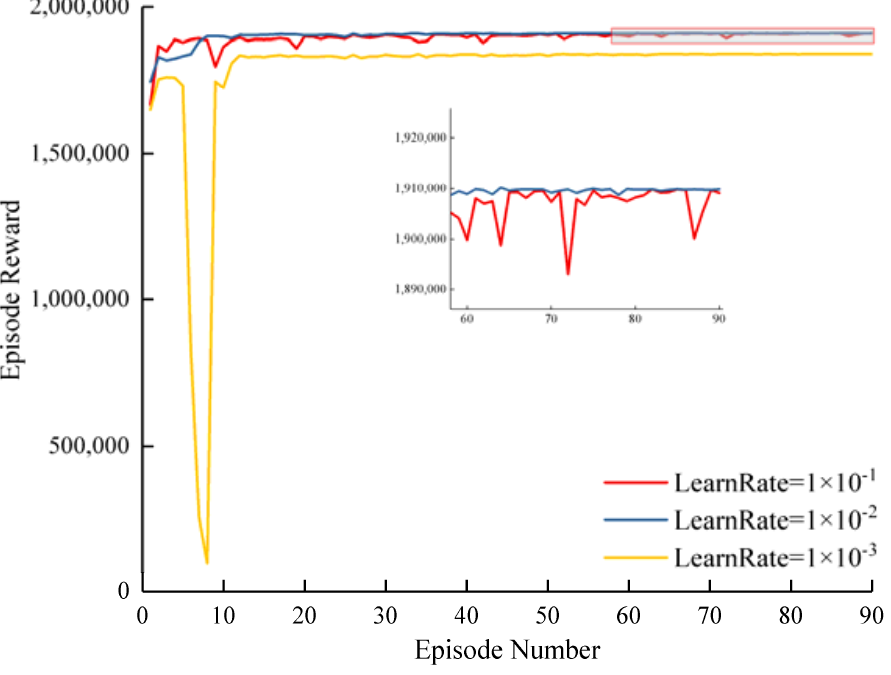
Figure 5. Algorithm convergence with different learning